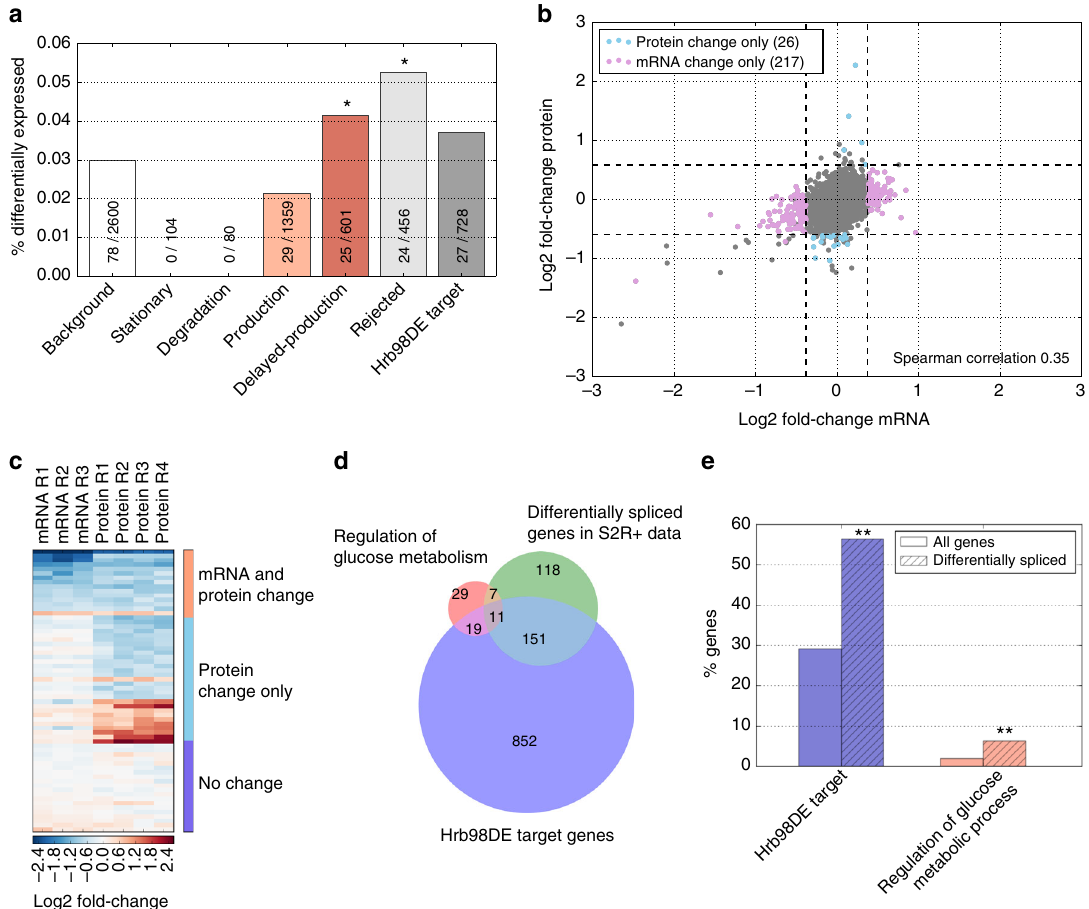
Fig. 7 Hrb98DE post-transcriptionally regulates glucose metabolism. a Proteome changes upon in vivo knockdown of HRB98DE during Drosophila development. Bars show the percentage of all genes within each protein class that are differentially expressed upon Hrb98DE knockdown. Absolute numbers are also shown (differentially expressed proteins in class/number of all proteins in class). Signi fi cant overrepresentation of differential expression is observed in the rejected and delayed-production categories and preferentially contain an Hrb98DE motif in their mRNA sequence, when compared to the background of all expressed genes (left bar). * indicates p < 0.05 using a hypergeometric test. b Transcriptome and proteome changes upon knockdown of HRB98DE in S2R + cells, shown as a scatterplot of mRNA vs. protein fold-changes. Signi fi cant cases of only mRNA changing (pink) or only protein changing (light blue) are highlighted. Dashed lines indicate thresholds of fold-changes for mRNA (absolute log2 fold-change > 1.3, BH corrected p value < 0.05) or protein (absolute log2 fold-change> 1.5, nominal p value < 0.01). c Heatmap of fold-changes for mRNA and protein level of differentially expressed genes upon Hrb98DE knockdown in S2R + cells (in 14 cases mRNA and protein are both signi fi cantly changing, in 26 cases only signi fi cant change on protein level, 4149 with no change of mRNA or protein). For genes with no signi fi cant change in either mRNA or protein only a subset of 20 randomly chosen genes is shown. d Splicing changes at the mRNA level upon knockdown of HRB98DE in S2R + cells. Venn diagram showing differentially spliced genes upon Hrb98DE knockdown and their overlap with genes previously identi fi ed as Hrb98DE targets or genes annotated as regulators of glucose metabolic processes (GO:0010906). The previously identi fi ed Hrb98DE targets were de fi ned by combining Hrb98DE targets reported by Blanchette et al. (2009), Ji and Tulin (2016) 41 and mRNAs with the Hrb98DE binding motif. e Differentially spliced genes are enriched for Hrb98DE targets (blue striped bar) or genes annotated as regulators of glucose metabolic processes (red striped bar), when compared to the background of all detected genes (clear bars). ** denotes signi fi cance with a p value below 0.01 (hypergeometric